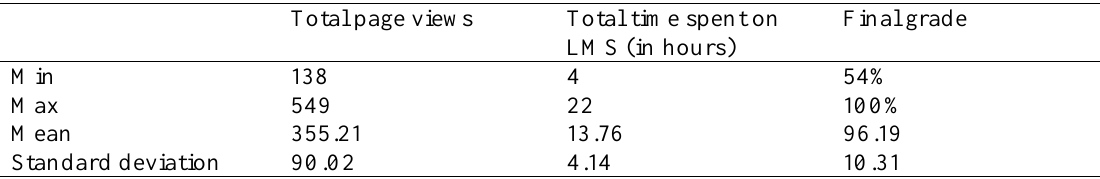
Table 3 Student Activity in LMS and Final Grade Total page views Total time spent on Final grade LMS (in hours) Min 138 4 54% Max 549 22 100% Mean 355.21 13.76 96.19 Standard deviation 90.02 4.14